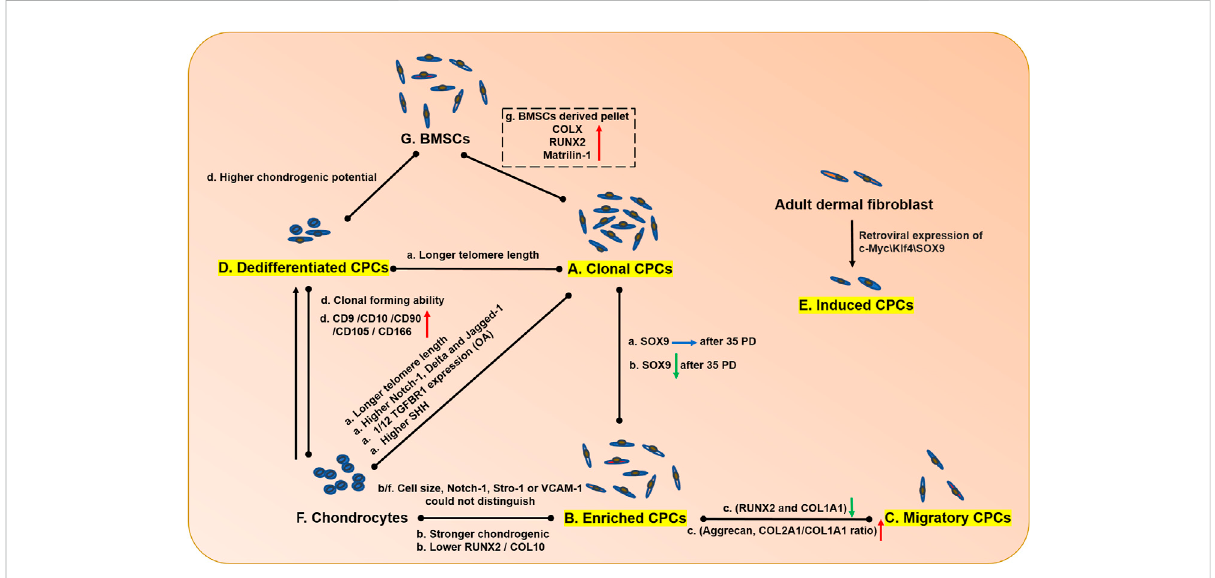
FIGURE 2 The comparison of CPCs from different sources, chondrocytes and BMSCs. The CPCs isolated from different methods exhibited different properties. The capitalized (A – G) means single cell derived clonal CPCs, enriched CPCs, migrated CPCsfrom cartilage tissue, dedifferentiated CPCs derived from chondrocytes and speci fi c factors induced CPCs, chondrocytes and BMSC, respectively. The capacities of proliferation differentiation, and migration were compared. a, b, c, d, e, f, g in lowercase means the cell properties in A, B, C, D, E, F, G cells compared with cells being connected by line, respectively. The red arrow means upregulation; the green arrow means downregulation; the blue arrow means unchanged; the black arrows mean cell